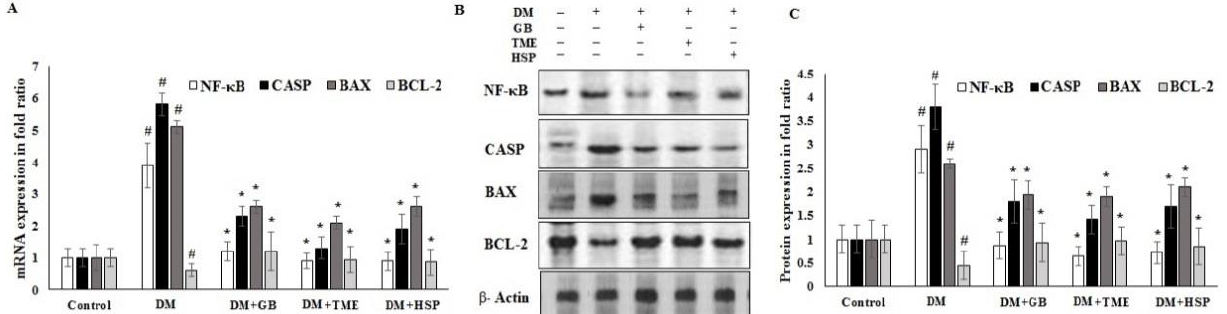
Figure 6. ( A ) Effects of TME, HSP, and GB on the mRNA and protein expression of NF- κ B, cleaved caspase-3, BAX, and BCL2 markers of rat pancreatic tissue. The effects of TME, HSP, and GB on NF- κ B, cleaved caspase-3, BAX, and BCL2 markers of rat pancreatic tissue were evaluated by real-time PCR. The mRNA of NF- κ B, cleaved caspase-3, BAX, and BCL2 markers were quantified using quantitative real-time PCR. GAPDH was used as an internal mRNA control. ( B , C ) Alterations in the status of protein expression in response to TME, HSP, and GB were inspected using Western blot. β -Actin was utilized as a control. The experimental data are shown as mean ± SD of triplicate values; * significant difference between DM groups. # significant difference between DM group